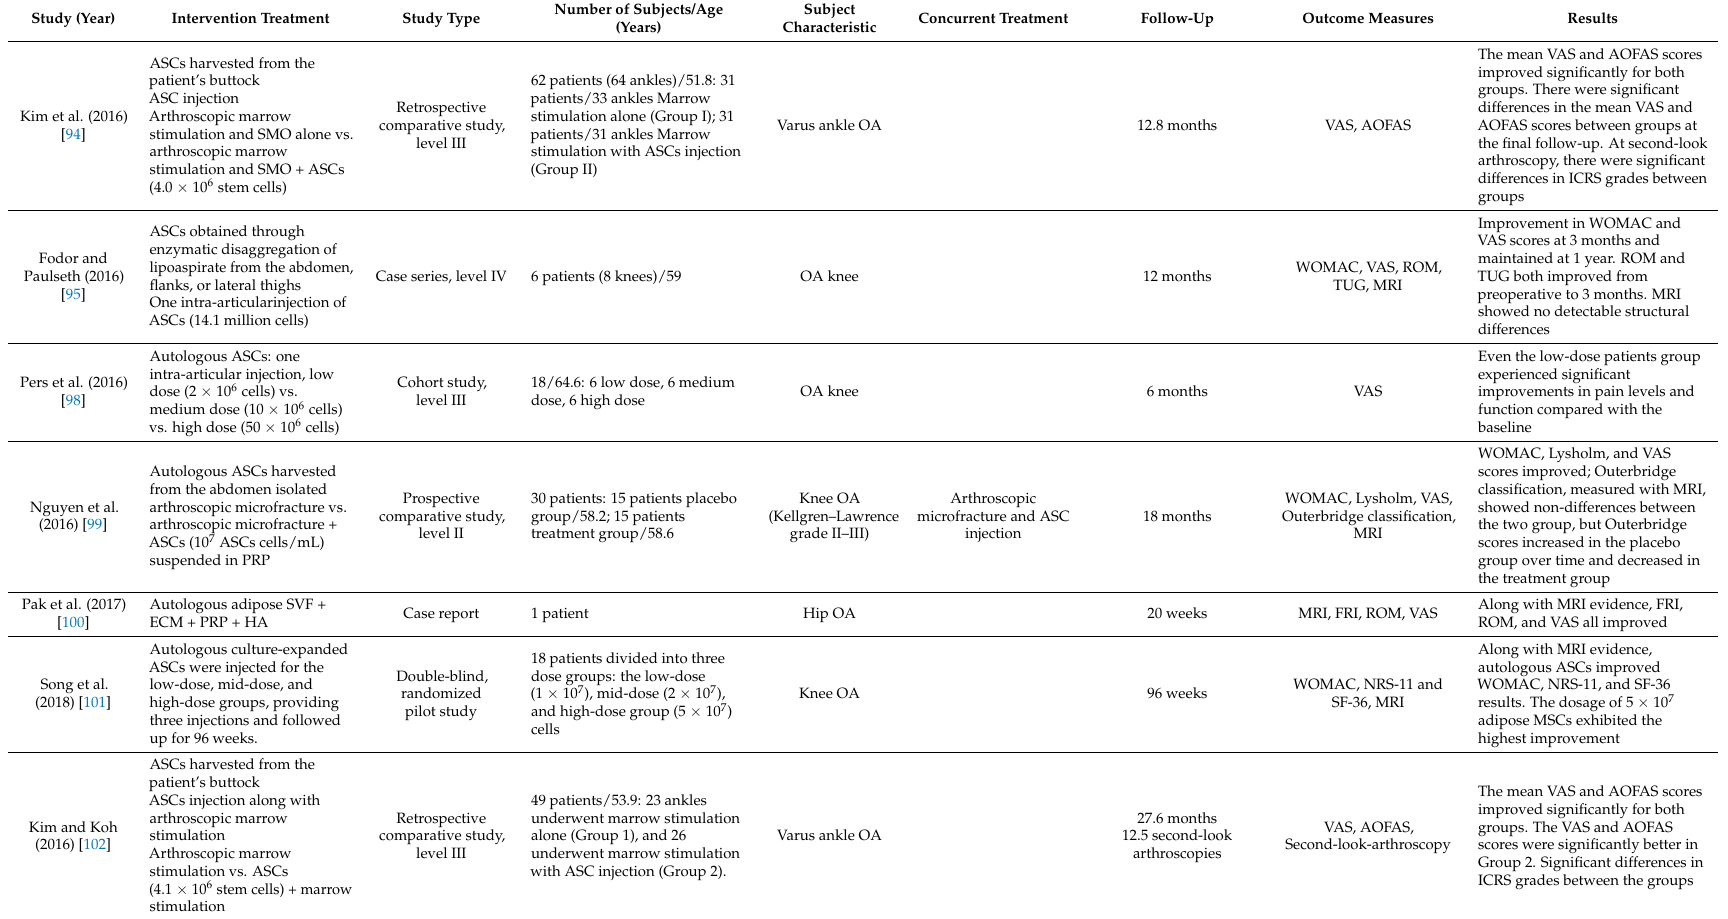
Table 1. Clinical studies on treatments with adipose tissue-derived stem cells and adipose stromal vascular fraction cells for cartilage